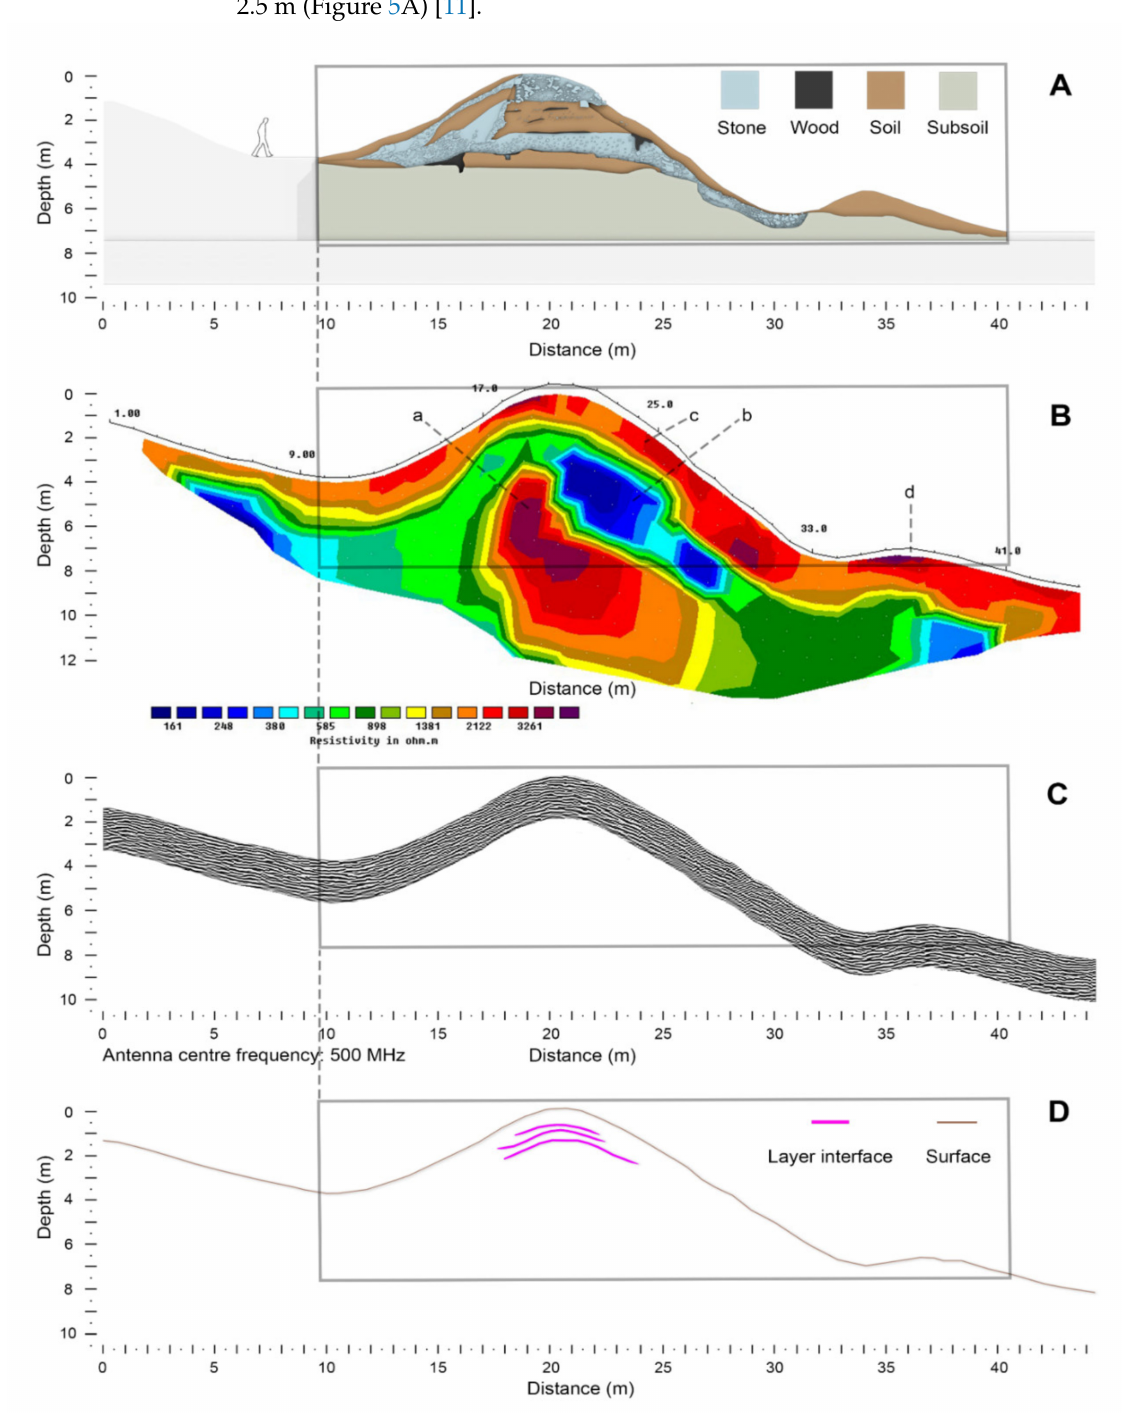
Figure 4. Bojn á I. ( A ): Profile of the hillfort’s fortification based on the results of archaeological exca- vation ([38], Figure 7). ( B ): Electrical resistivity tomography model in Wenner configuration. ( C ): GPR vertical time/depth radarogram from an antenna with 500 MHz centre frequency. ( D ): Interpretation of the GPR